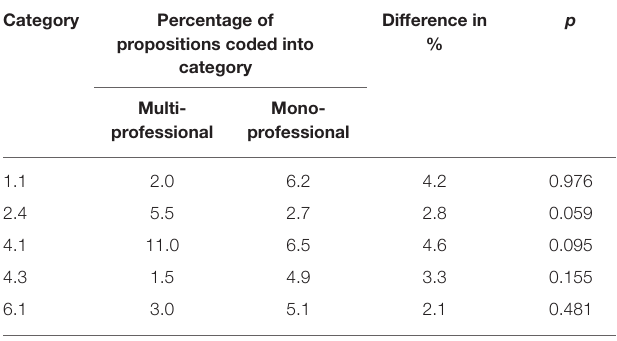
TABLE 4A | Teacher trainees in multi- compared to mono-professional teams at t1: relative frequency of propositions coded into the respective categories. Category Percentage of propositions coded into